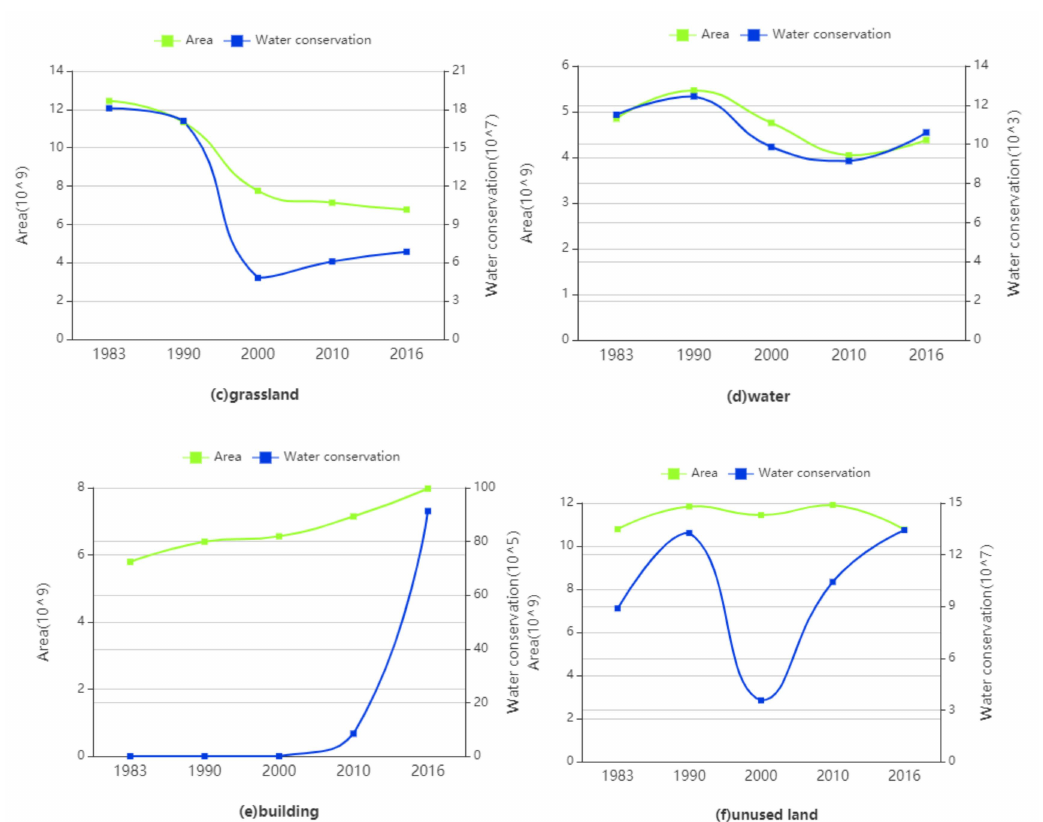
Figure 7. The change trends of water retention capacity of ( a ) cultivated land, ( b ) forestland, ( c ) grassland, ( d ) unused land, ( e ) water, and ( f ) buildings from 1983 to 2016.